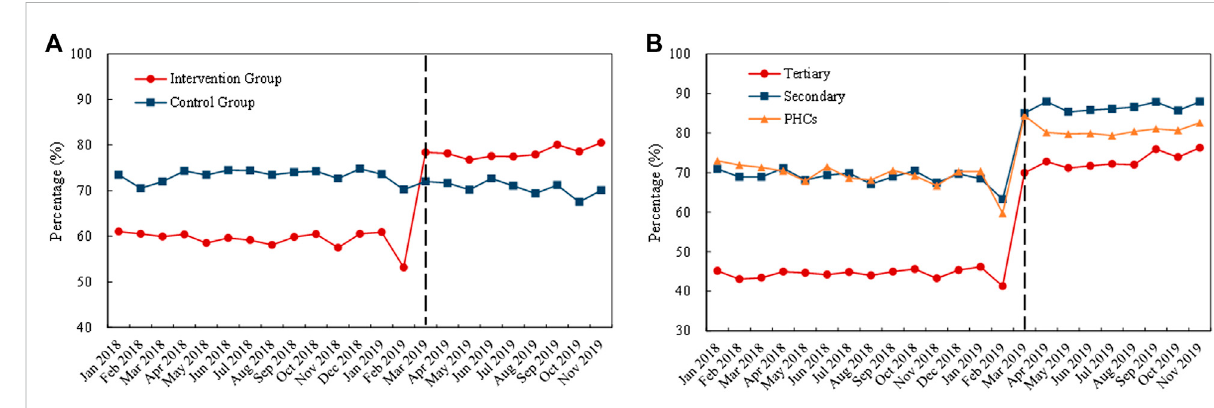
FIGURE 5 Trends in the volume proportion of generic drugs during January 2018 to November 2019: (A) volume proportion of generic drugs in the intervention group and control group (B) volume proportion of generic drugs in intervention group by healthcare setting. Note: PHCs, primary healthcare centers.